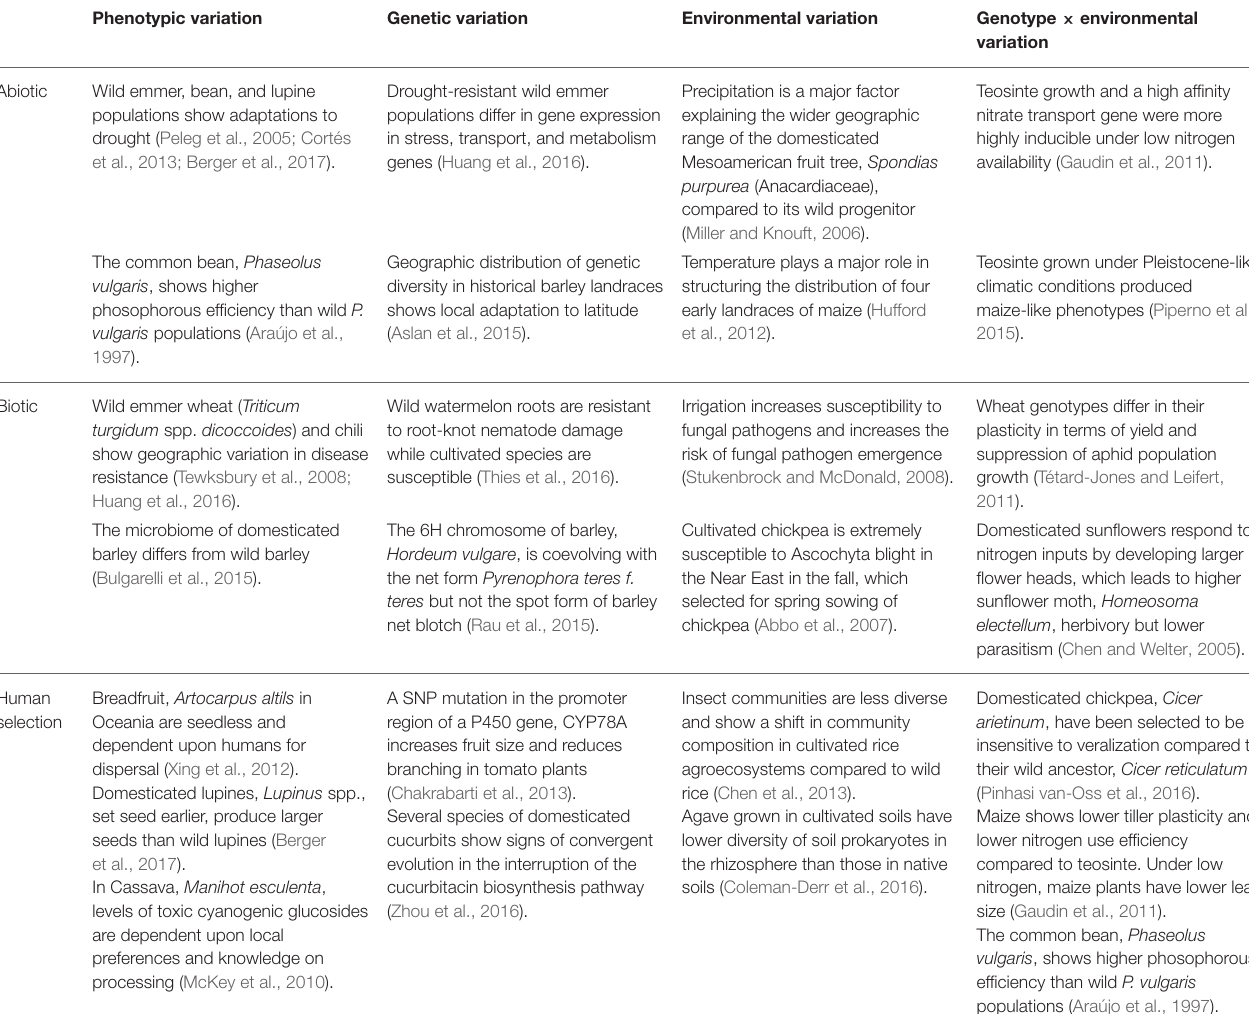
TABLE 1 | Phenotypic variation ( V p ) in wild progenitors and landraces can be attributed to genetic variation ( V G ), environmental variation ( V E ), and variation attributed to genotype by environment interactions ( V GxE ). Phenotypic